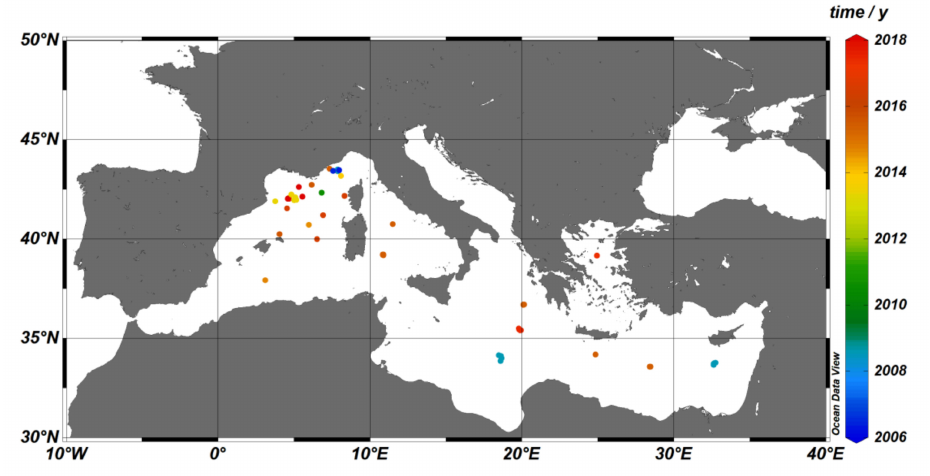
Figure 6. Positions of considered Argo floats, per year, in the Mediterranean Sea.